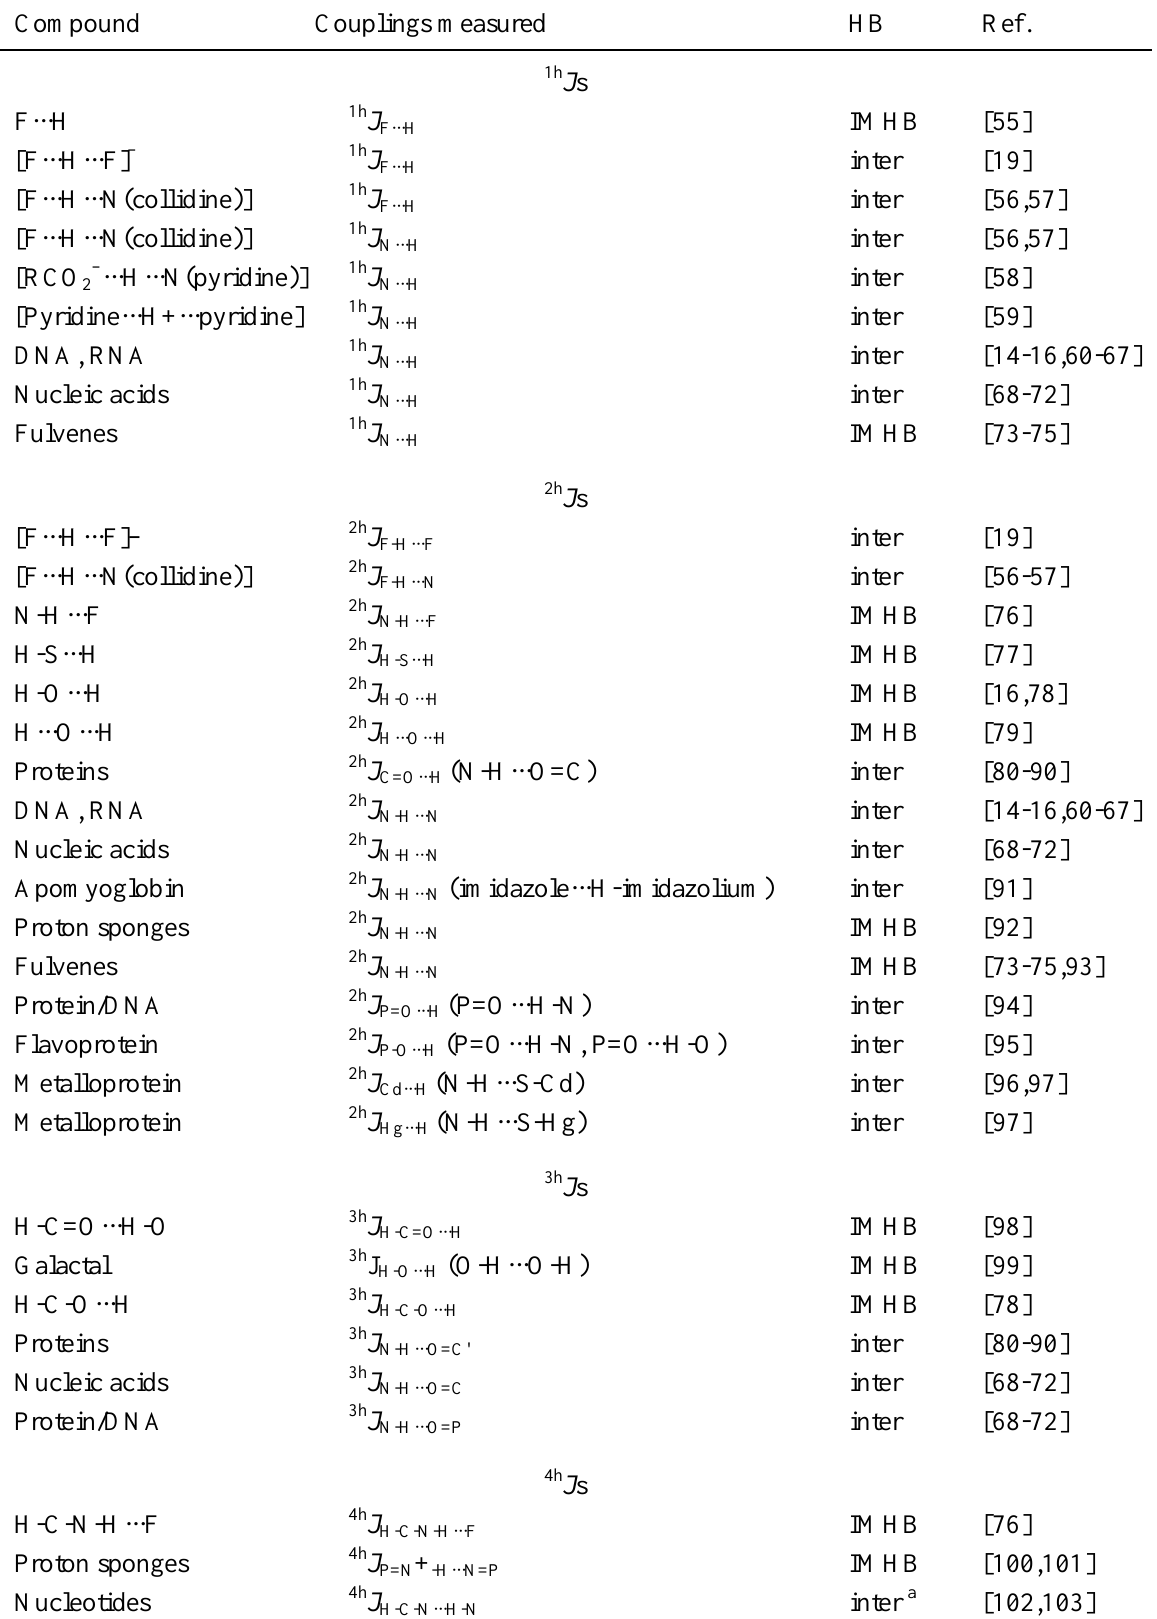
Table 7 . Experimental coupling constants through hydrogen bonds Compound Couplings measured HB